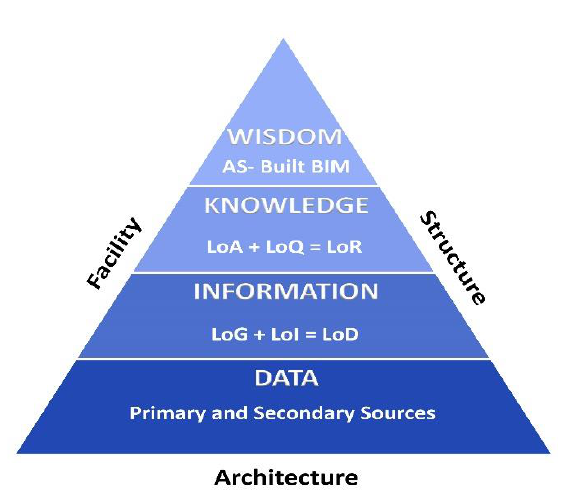
Figure 7: The DIKW hierarchy and the process of knowledge and modelling of an architectural